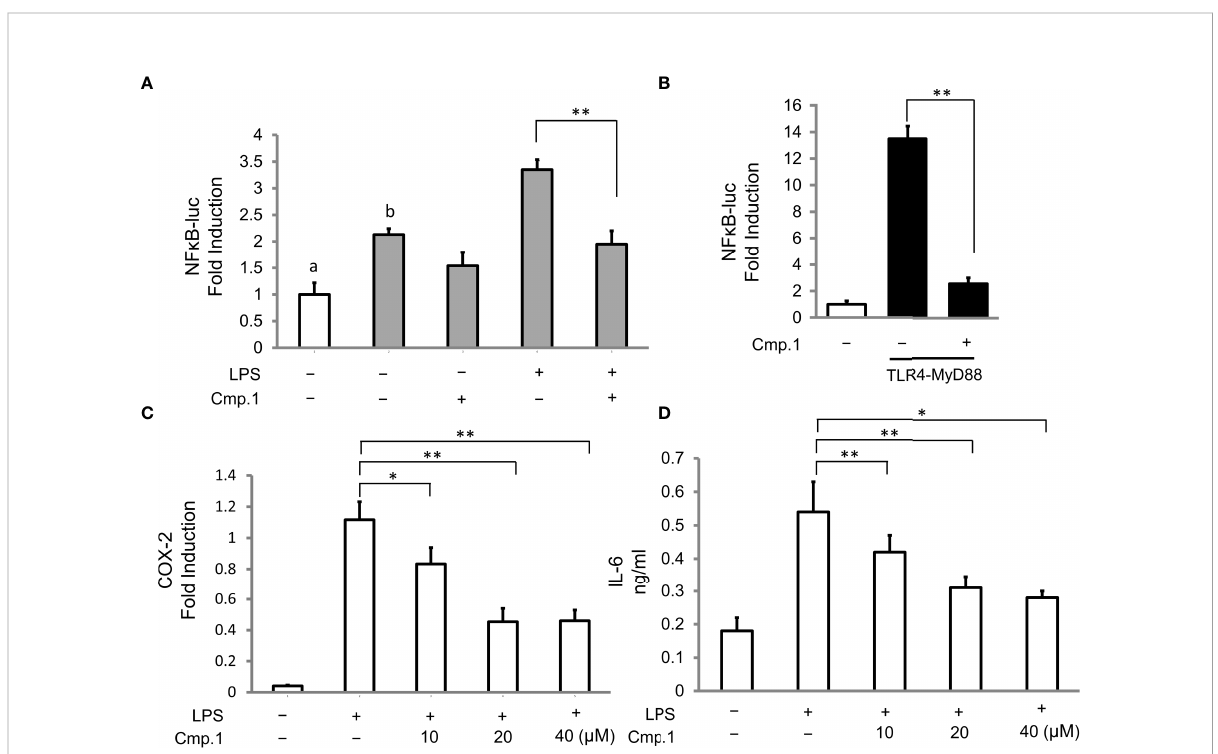
FIGURE 4 The inhibitive activity of compound 1 on NF- k B, COX-2, and IL-6 production. 293T cells were transfected with the expression of TLR4 (A) or TLR4 plus MyD88 (B) and then stimulated with or without LPS (0.1 m g/mL) in the presence of 1 (20 m M) for 16 (h) 293T cells without TLR4 transfection are marked with “ a ” , and 293T cells with TLR4 transfection are marked with “ b ” ; RAW264.7 cells were pretreated with the indicated amount of 1 followed by stimulation with LPS (0.1 m g/mL) for 16 (h) COX-2 production was analyzed by Western blotting and presented as relative light units from immuno fl uorescence microscopy (C) , and IL-6 production was determined by ELISA as the cytokine accumulation in the medium after treatment (D) . Double asterisks denote a statistically signi fi cant difference from the control group at P<0.01 and a single asterisk denotes P<0.05 by Tukey ’ s test. Data are representative of at least three independent